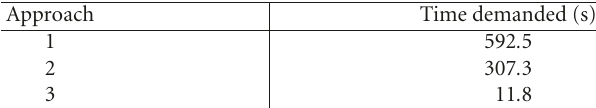
Table 2: Results for the recursive FIR filterbank.